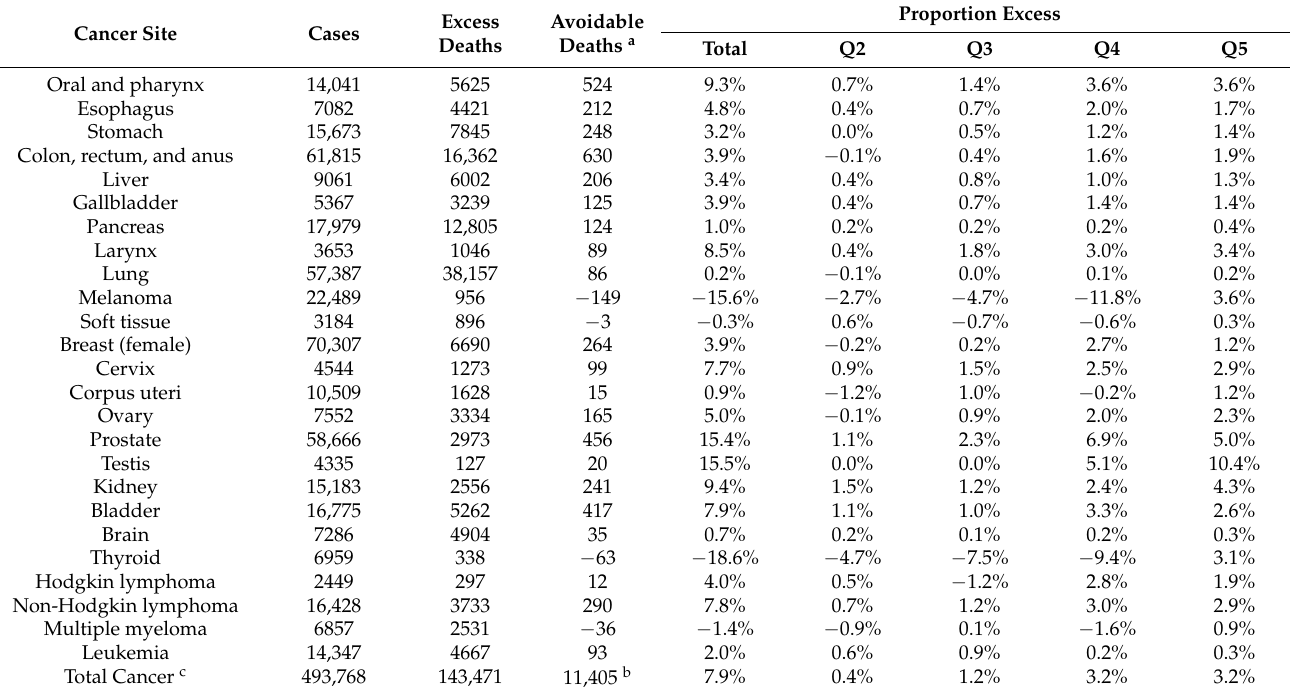
Table 5. Estimated annual number of avoidable excess deaths among cancer patients associated with area-based deprivation on a municipality level within 5 years of diagnosis for patients diagnosed in 2013–2016 in